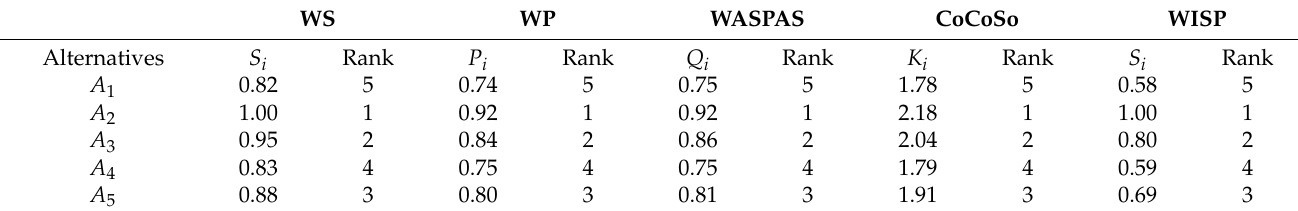
Table 13. Ranking of alternatives on the basis of 10 virtual respondents and the proposed grey approach.